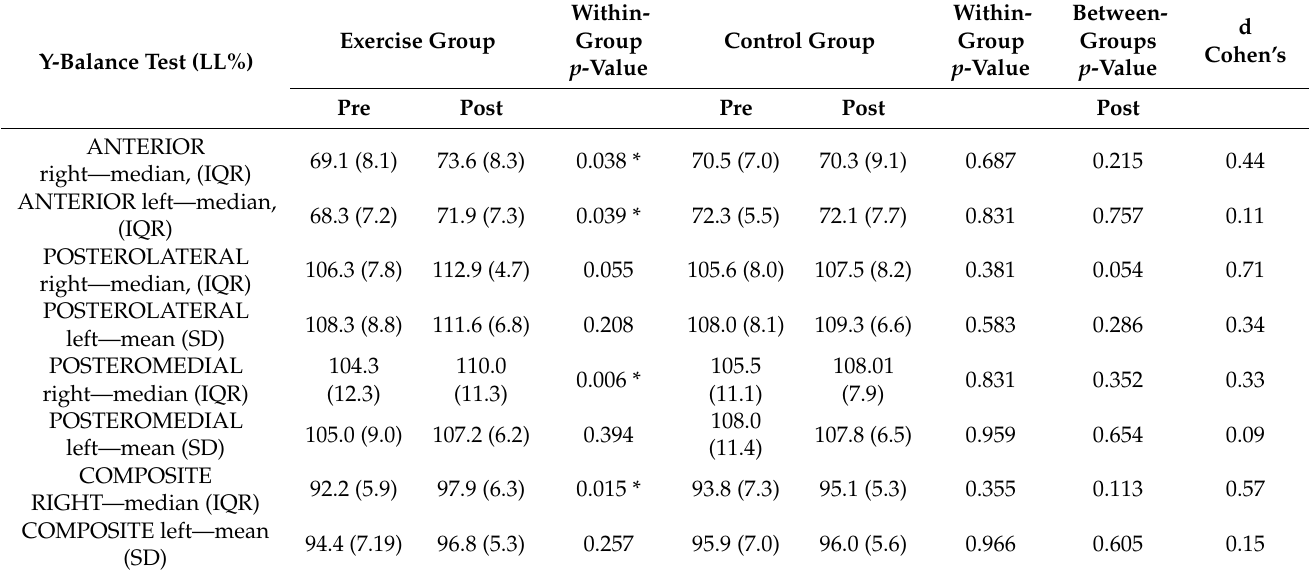
Table 4. Comparison within-group and between group for the Y-Balance